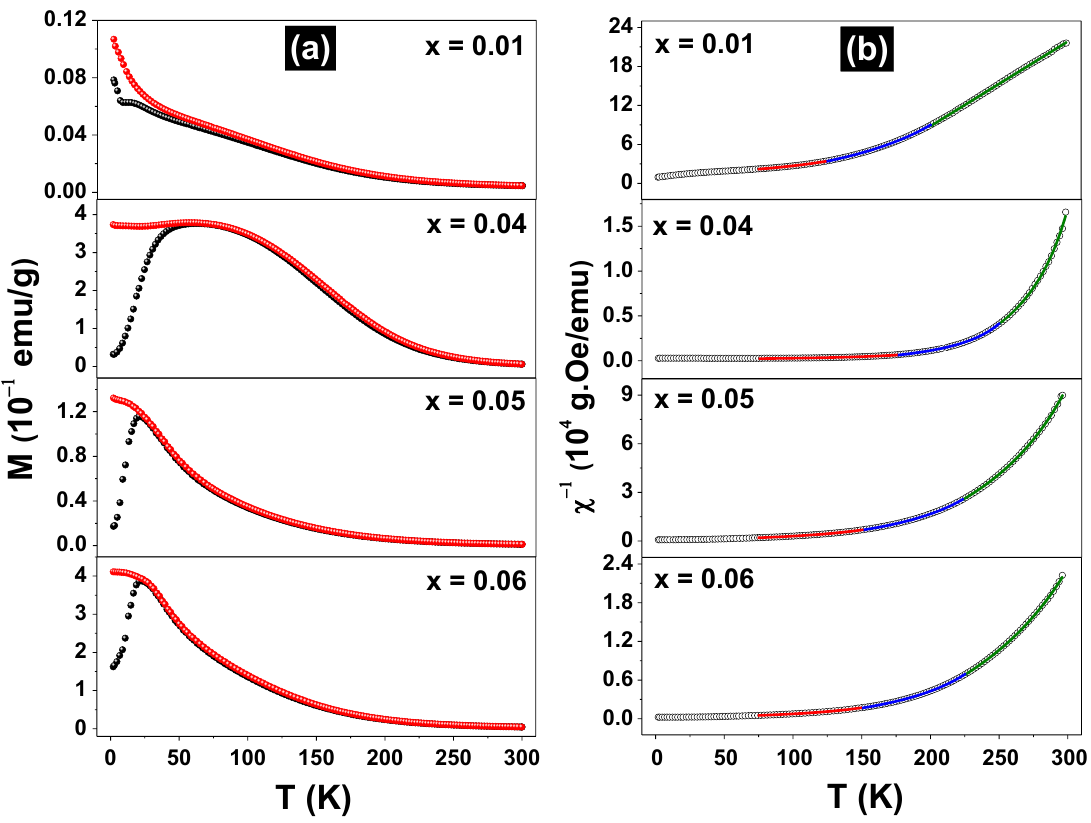
Figure 4. Zero field cooling ( • ) and field cooling ( • ) curves, taken with a probe field of H = 100 Oe for the (Zn 1-x Fe x )O samples ( a ) and the corresponding reciprocal susceptibility fitted curves ( b ). For the sample x = 0.01, the ZFC and FC curves grew monotonically, decreasing the temperature to the lowest limit. However, a magnetic transition or spin reorientation effect in the temperature range of 6–20 K may occur in this sample. The ZFC / FC curves for the x = 0.04, 0.05, and 0.06 samples have di ff erent shapes from the previous ones, but clearly reveal magnetic transitions at 25 K (x =